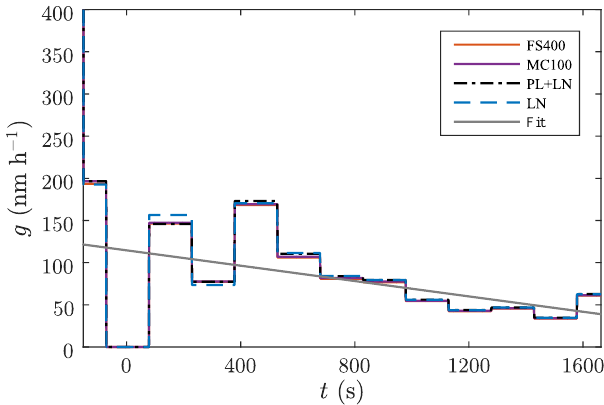
Figure 6. Time series for the new particle formation rates in the chamber event that produce the measured concentrations, N , S , and M , the most accurately compared to the measured ones, using dif- ferent models. The fit denotes a bell-shaped function fitted to the values from the FS400 model.